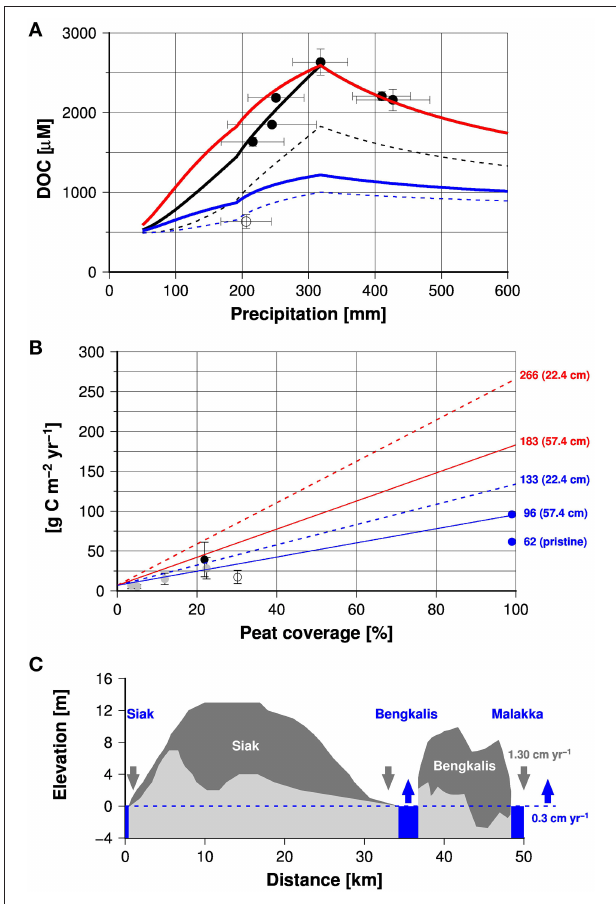
FIGURE 3 | (A) DOC end-member concentrations obtained from data measured between 2004 and 2009 (black circles) and in 2013 (open circles) in the Siak ( Table 1 ). Blue, red, and black lines show DOC end-member concentrations calculated by the model experiments number one (5333 µ M), two (16,222 µ M), and three, respectively. The broken lines show also results of the experiment number one and three but instead of an evapotranspiration rate of 37.9% for disturbed peatlands an evapotranspiration of 67.7% was used which is assumed to be characteristic for pristine peat swamps. (B) Mean DOC yields (discharge into the ocean) obtained from DOC end-member concentrations and the mean precipitation rates (1987–2013) in the respective river catchments (gray circles) vs. peatland coverage of the catchments (data are given in Table 1 ). The black and open circle represent Siak and Rokan data. Blue dots show data from rivers draining pristine and disturbed peatlands in Borneo (Moore et al., 2013). The red and blue lines show the area normalized DOC leaching rates and riverine DOC yields, respectively, derived from the model vs. peatland coverage of the catchments. Broken and solid lines indicate model results obtained by assuming an acrotelm depth of 22.4 and 57.4cm, respectively. Numbers show leaching and export rates at 100% peat cover. (C) Cross-section through the Siak and Bengkalis peat domes (redrawn from Supardi and Subekty, 1993). The respective profile line is given in Figure 1B . Dark and light colored areas represent the peat and underlying subsoils. Dark and blue arrows show the reduction of peat thickness caused by peat carbon losses and global mean sea level rise (Watson et al.,